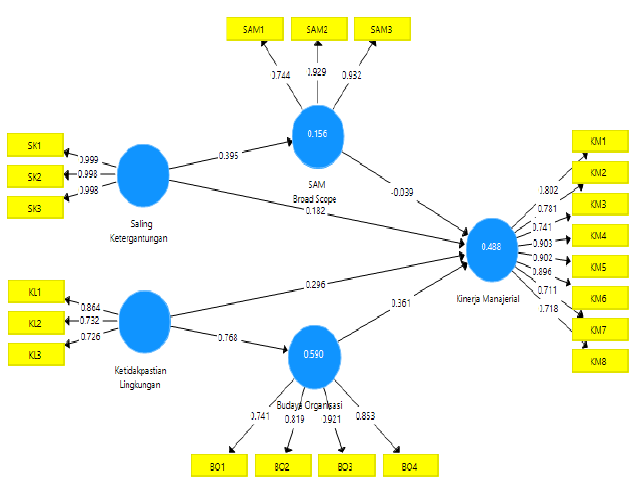
Fig. 2. Research Model Path Source: SmartPLS 3.3